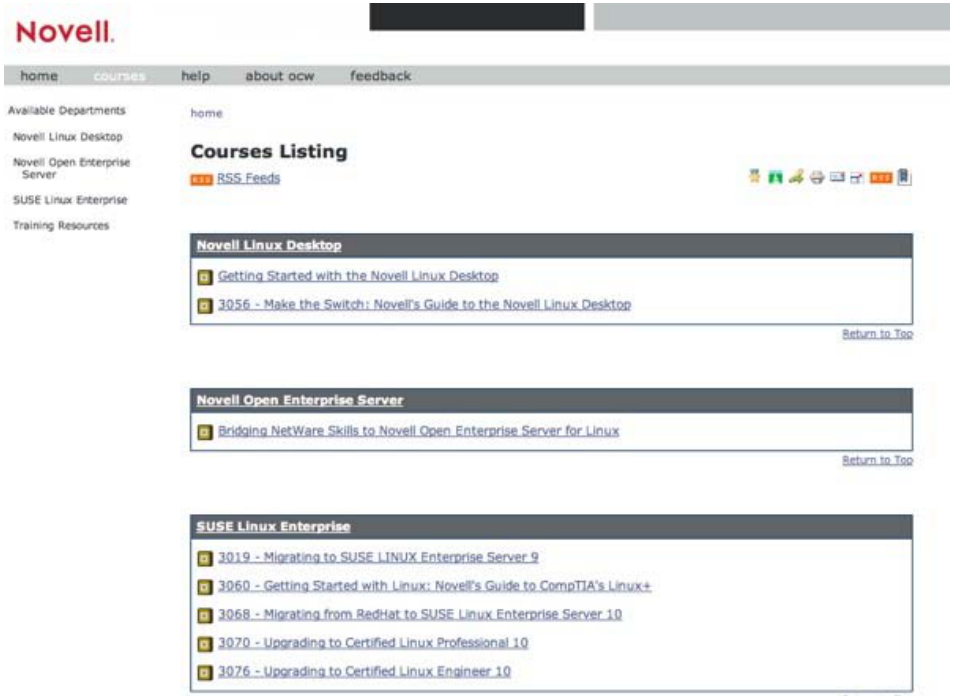
Figure 2. Image of Novell's OpenCourseWare